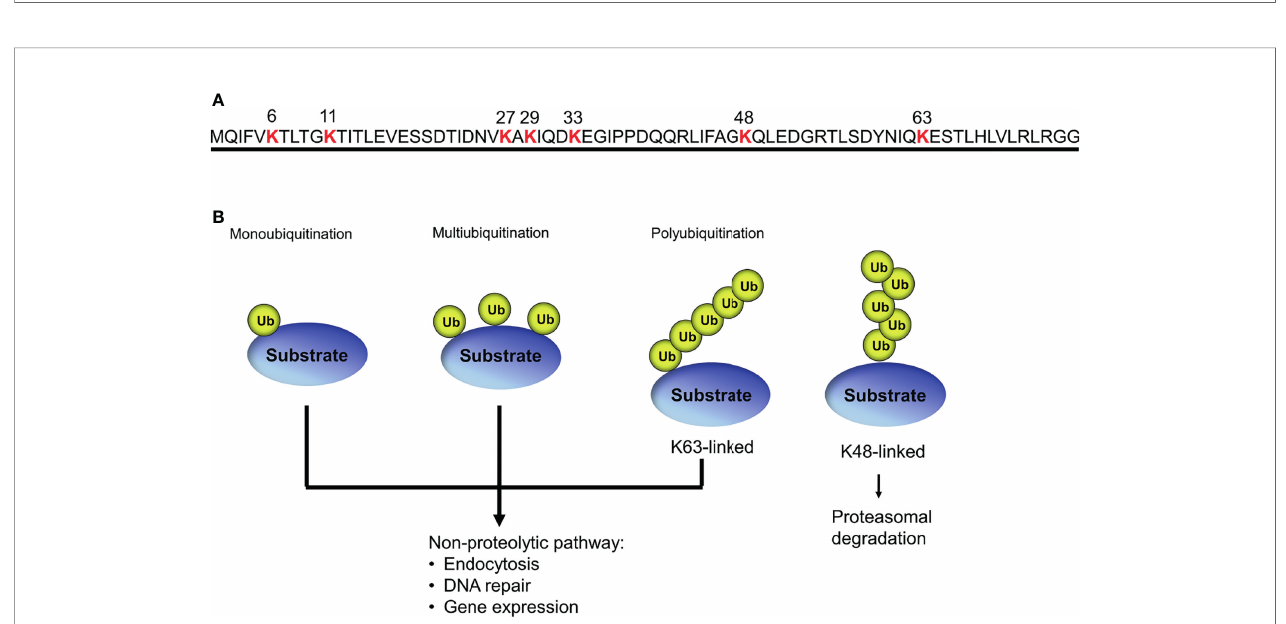
FIGURE 2 | Different forms of ubiquitin modi fi cation. (A) Seven speci fi c lysine residues in ubiquitin used for polyubiquitin chain formation. (B) Different types of ubiquitination lead to different biological